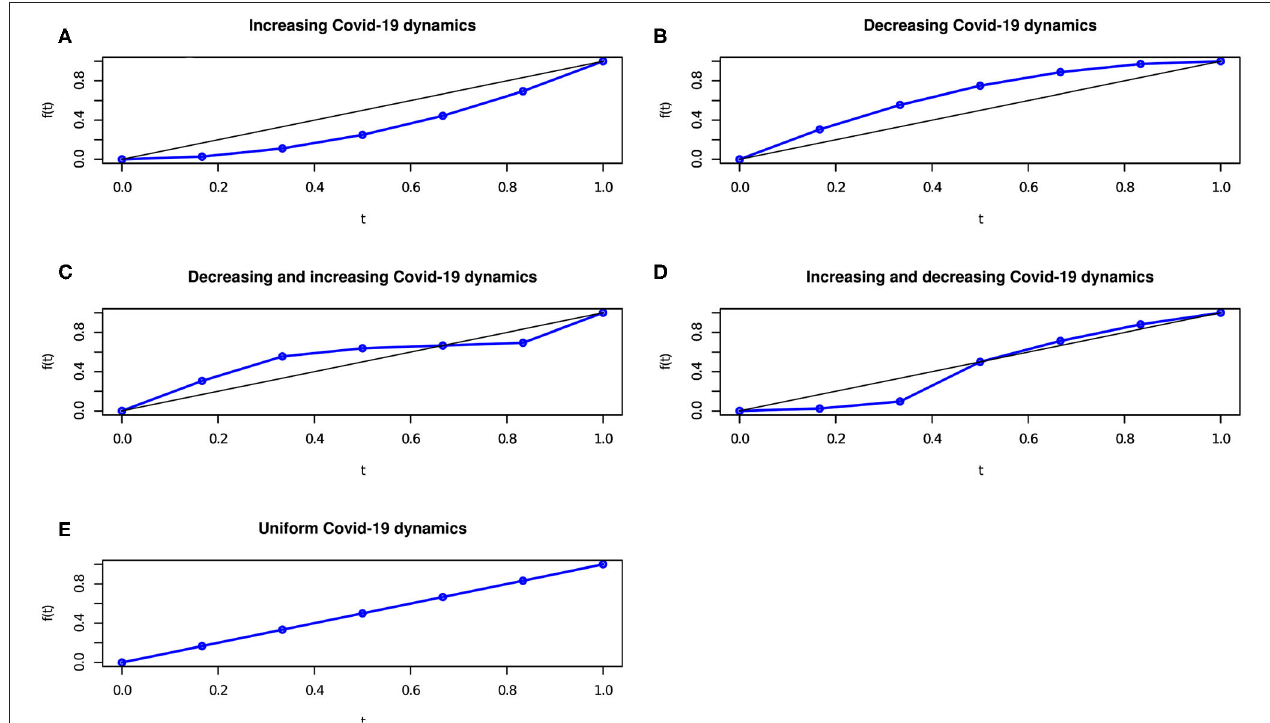
FIGURE 1 | The Covid-19 dynamics behavior in scenarios (A–E) in terms of concordance curve.